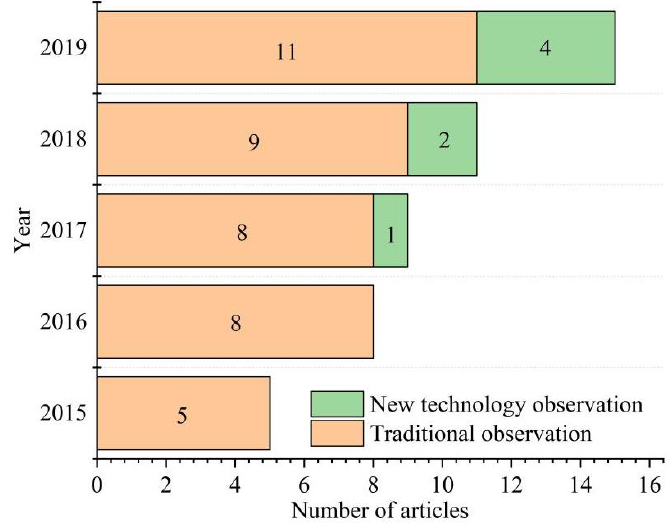
Figure 6. Number of publications by technology observation.